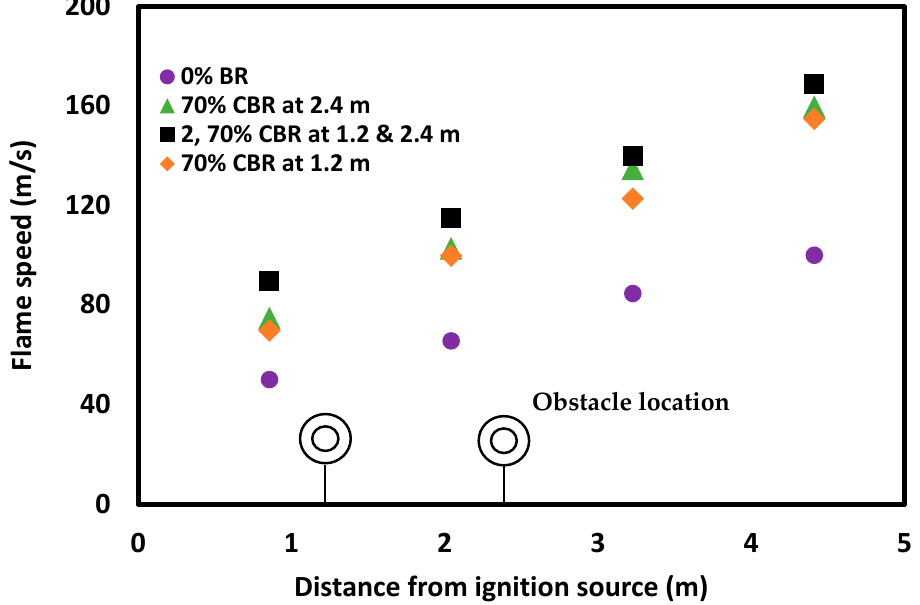
Figure 10. Flame propagation speed for experiments with a 10% methane concentration in a straight tube; in a tube with one 70% ori fi ce plate placed 1.2 m or 2.4 m from the ignition source; and in a tube with two 70% ori fi ce plates placed 1.2 and 2.4 m from the ignition source.